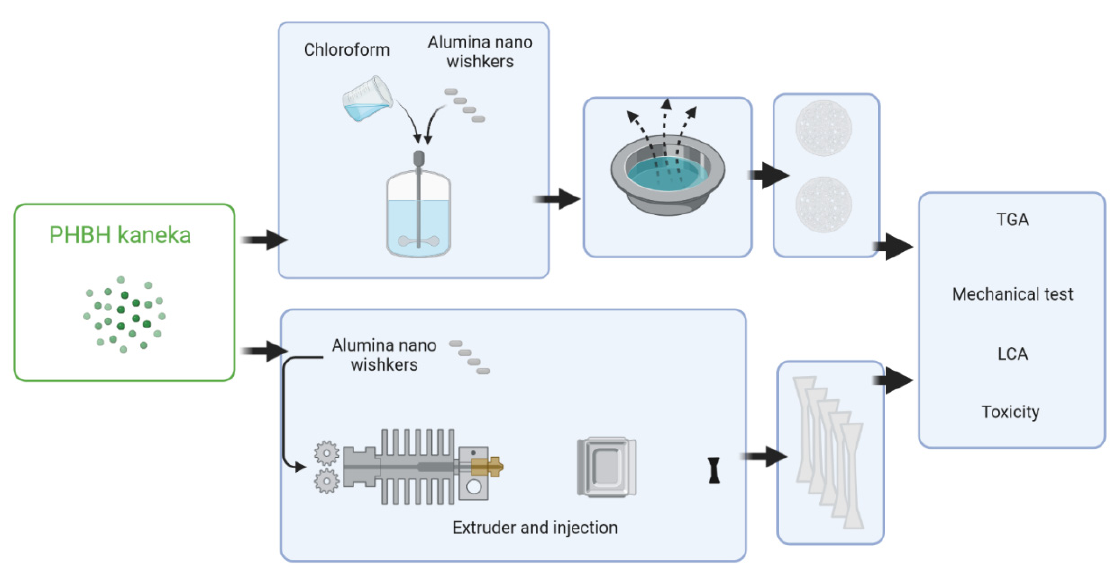
Figure 1. Schematic illustration of the sample production.